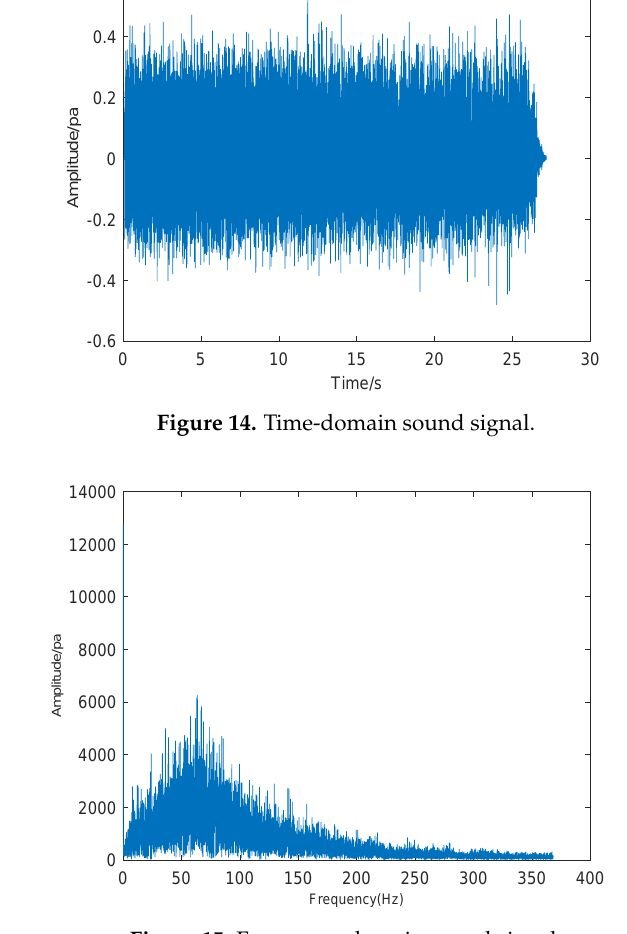
Figure 15. Frequency-domain sound